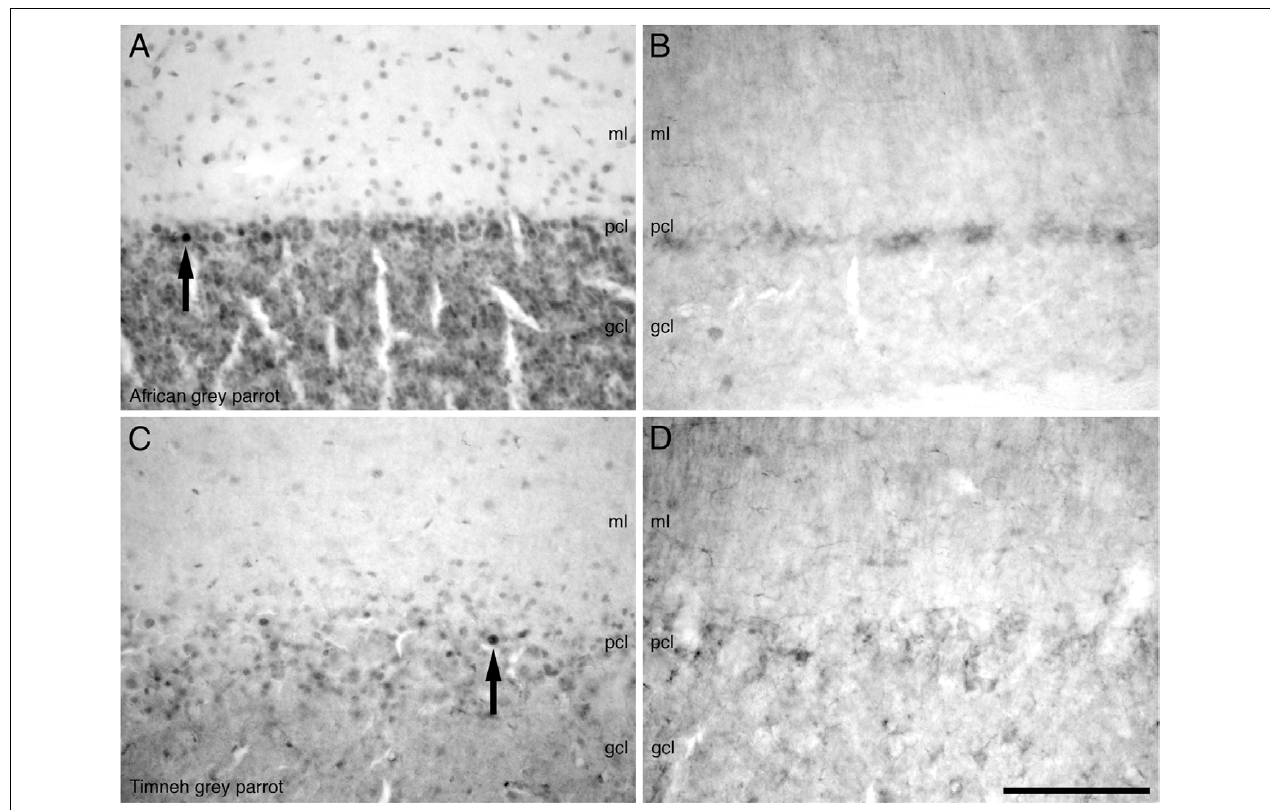
FIGURE 7 | Photomicrographs of PCNA – (A,C) and DCX (B,D) – immunostained coronal sections through the cerebellar cortex in the brains of the two parrot species – (A,B) – African grey parrot ( Psittacus erithacus ), (C,D) – Timneh grey parrot ( Psittacus timneh ). A clear similarity in the distribution of PCNA immunoreactive cells in the layers of the cerebellar cortex in the African grey parrot (A) and Timneh grey parrot (C) is observed. A similar distribution and staining intensity of DCX immunoreactive cells and fibers in the layers of the cerebellar cortex in the African grey parrot ( Psittacus erithacus ) (B) and Timneh grey parrot ( Psittacus timneh ) (D) is also observed. Note large and deeply stained PCNA immunoreactive cells ( arrows ) in the Purkinje cell layer (pcl) in both parrots. In all images dorsal is to the top and medial to the right. Scale bar in (D) = 100 µ m and applies to all. See list for